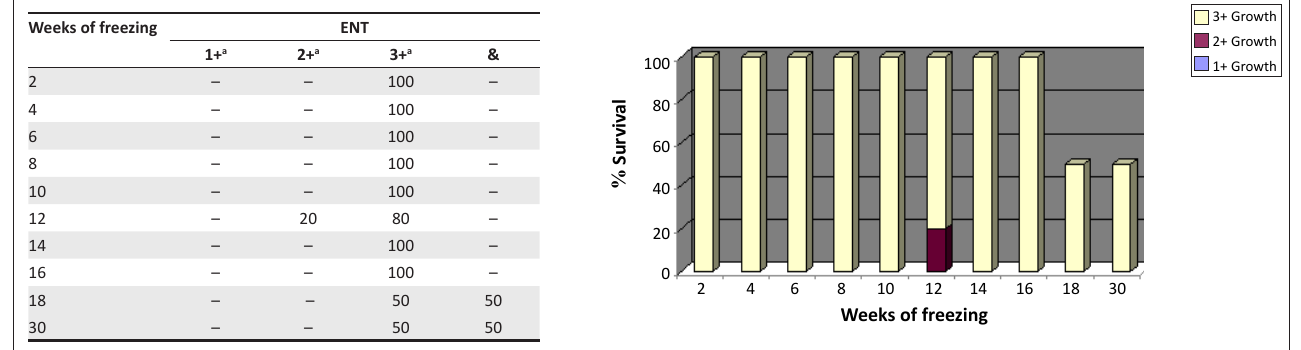
FIGURE 5: Percentage survival and viability of Enterococcus faecalis for cryopreserved samples.